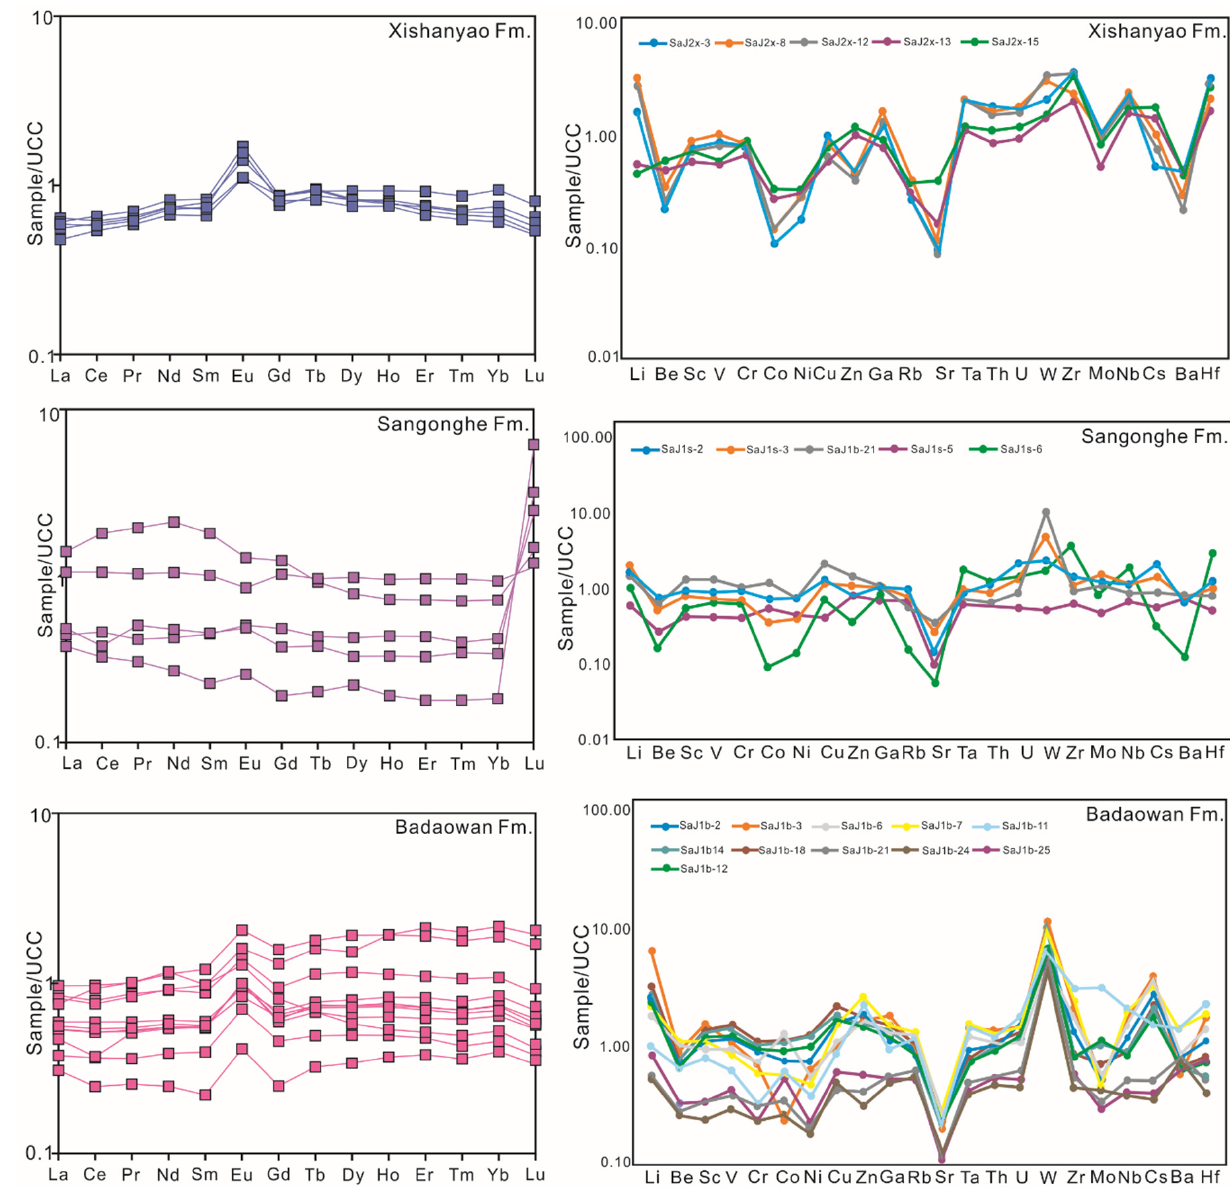
Figure 4. UCC-normalized trace elements and REEs of samples from the Su’asugou section in Yili Basin, NW China. UCC-normalization values are from Taylor and McLennan (1985) [55].